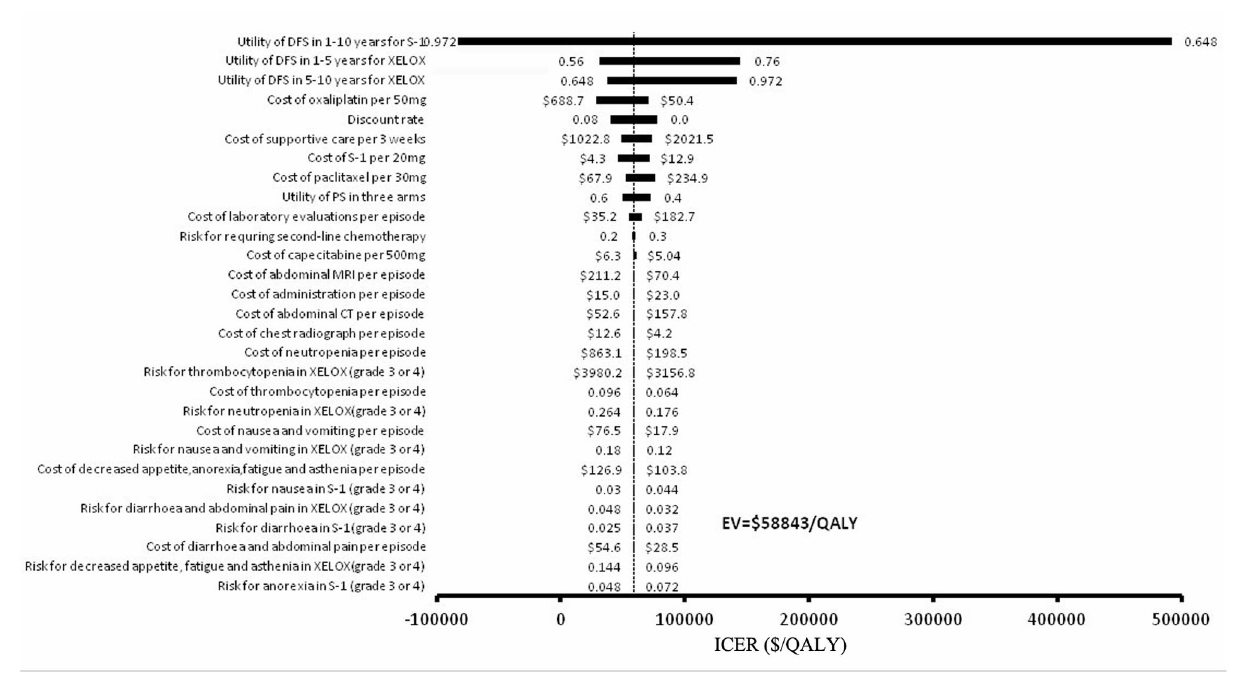
Figure 4. Tornado diagram for one-way sensitivity analysis of the capecitabine plus oxaliplatin and the S-1 treatment strategies. The parameters tested in the one-way sensitivity analysis are shown in the y-axis. The vertical dashed line represents $58,843/QALY (the results of base-case). doi: 10.1371/journal.pone.0083396.g004 Figure 5B indicates that compared to the SO strategy, the probability that S-1 was cost-effective was 81.8%..